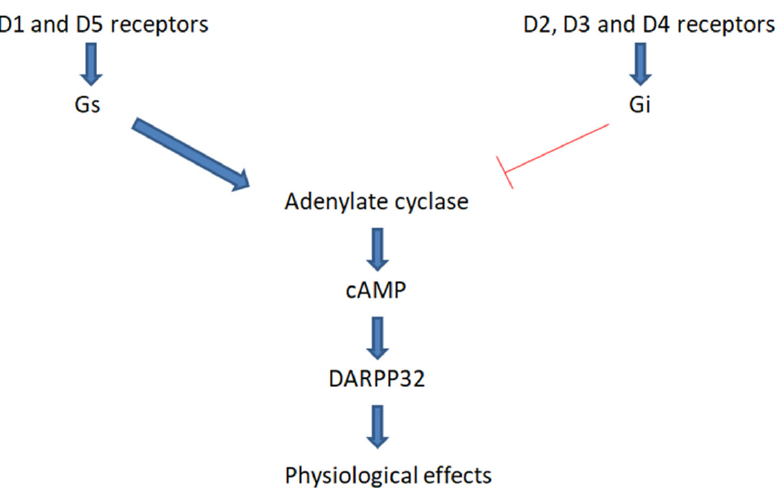
Figure 2. Mechanism of action of dopaminergic receptors. The binding of dopamine to the D1 and D5 receptors causes the activation of adenylate cyclase (AC) via the Gs protein. Activation of AC causes an increase in the concentration of cyclic adenosine monophosphate (cAMP), which results in an increase in the concentration of DA- and cAMP-regulated phosphoprotein of 32 kDa molecular weight (DARPP32), which penetrates into the cell nucleus, inducing a physiological response of the cell to dopamine. The reverse reaction is caused by the binding of dopamine to the D2, D3, and D4 receptors, which causes the inhibition of AC through the Gi protein.